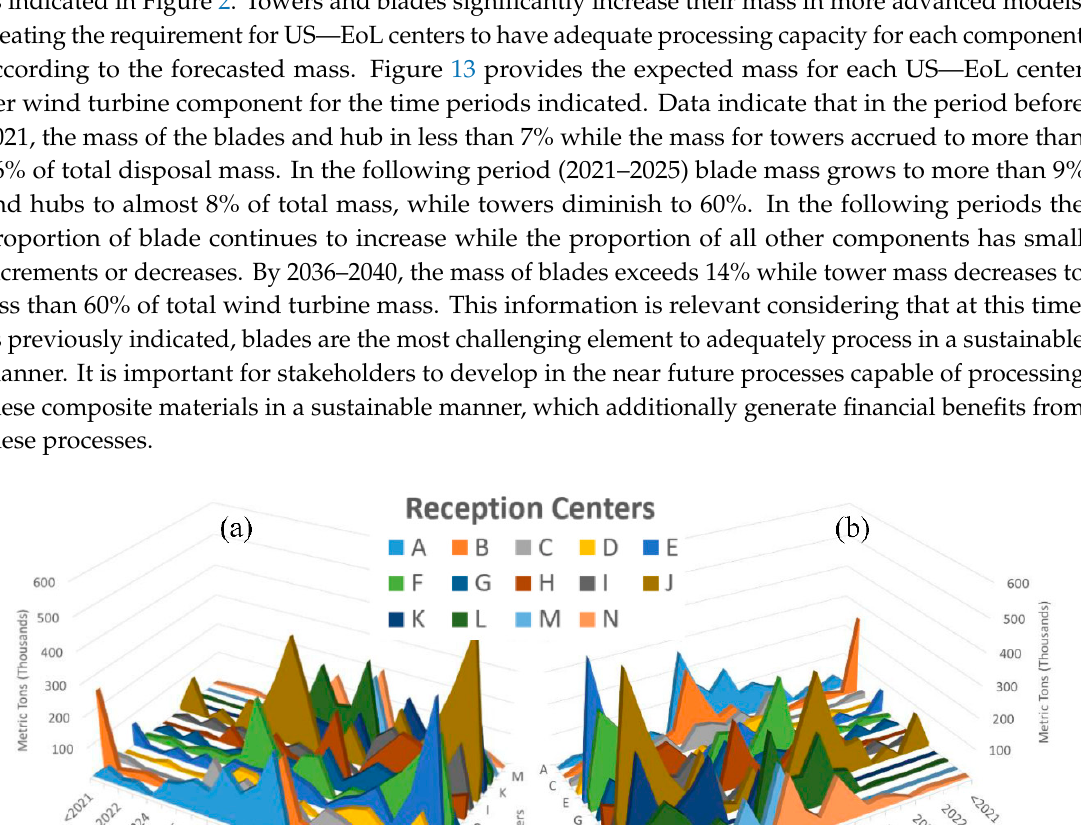
Figure 12. Performance of US—EoL centers over time considering decommissioning year from <2021 to 2040: ( a ) front view, ( b ) reverse view.